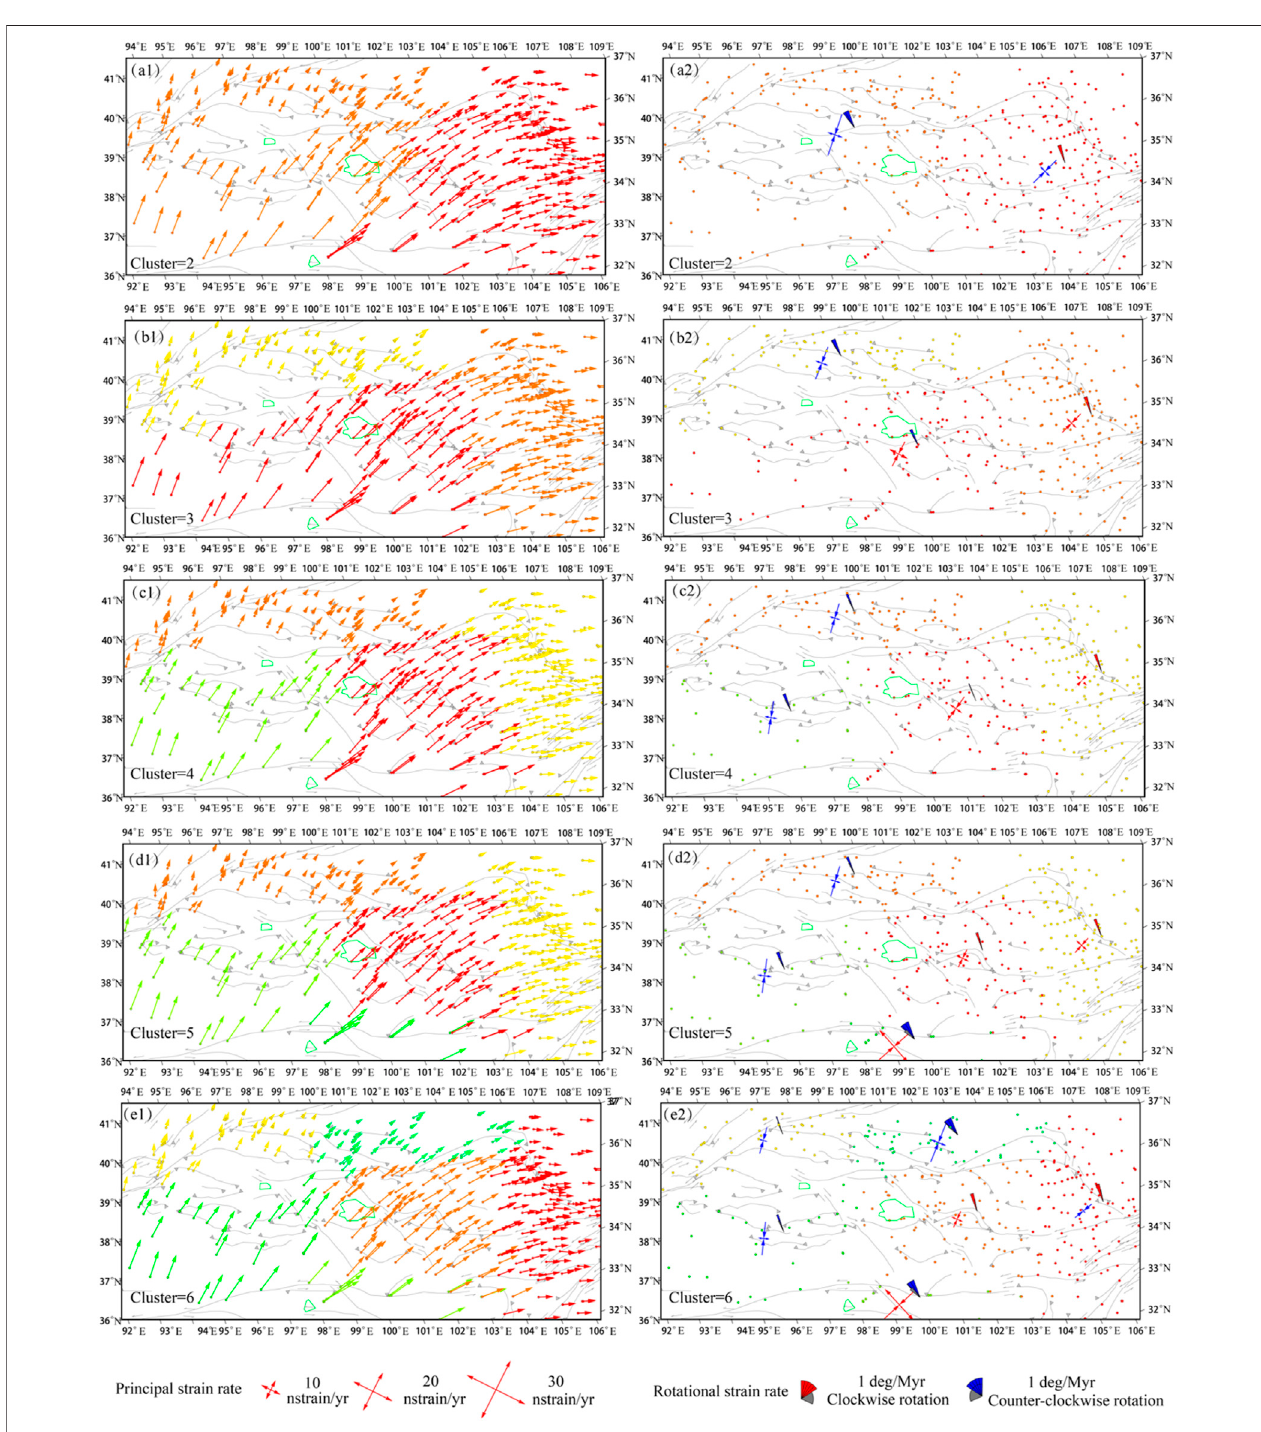
FIGURE 5 | Clustering velocity result for K = 2 − 6 and their calculated principal strain rate and rotational strain rate. a1 – e1 represent the velocity result of cluster analysis, and a2 – e2 represent the strain rate for each cluster.